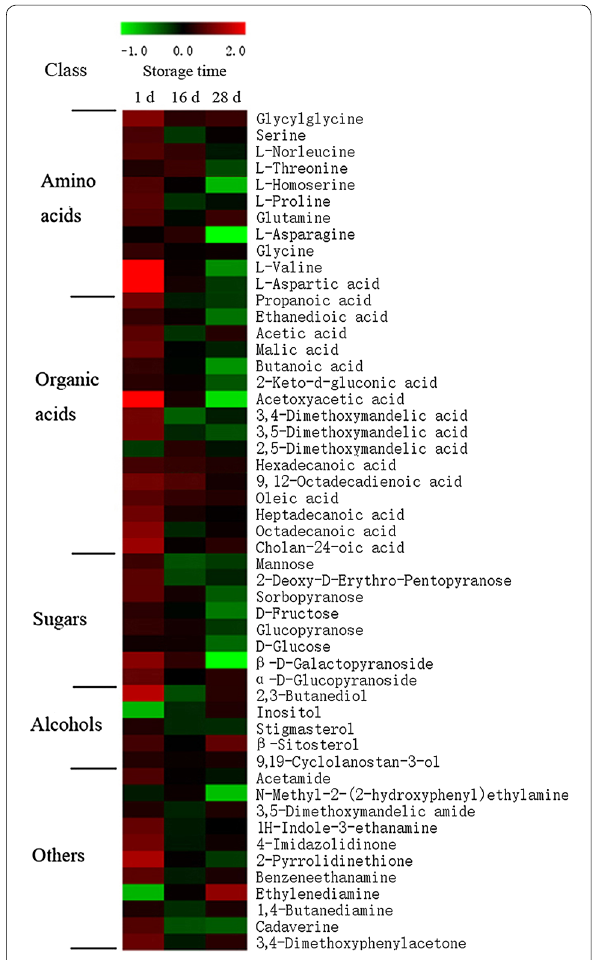
Fig. 7 A profile of the primary metabolites of banana fruit during storage. Samples from Control and NaDCC-treated fruit after 1, 16 and 28 days of storage were used for profiling the primary metabolites. The primary metabolites were determined with GC–MS. Fifty-one metabolites increased/decreased markedly in the peel tissues of NaDCC-treated fruit compared with the control fruit. The scaling numbers ( 1, 0, 2) stand for the log 2 transformation values of the − + ratio between treated and control